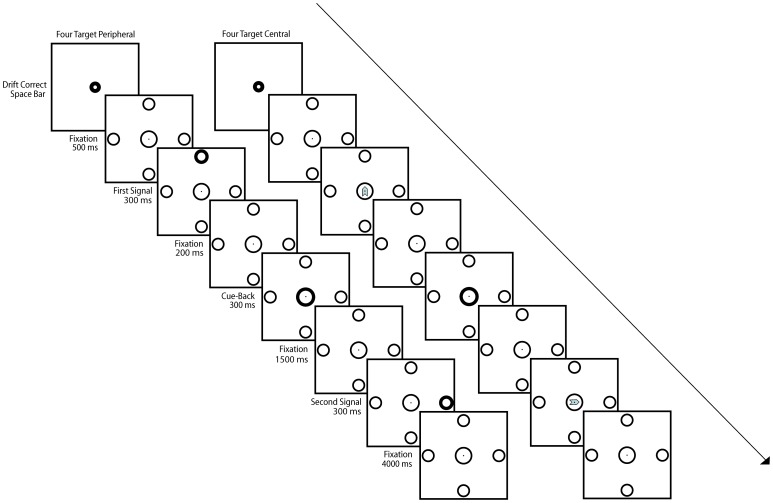
Sequence of Stimuli.Example stimuli and sequence timing from a single trial when peripheral (E1 and E3) and central (E2 and E4) signals were used to prompt responses. Each trial began with a drift correction procedure that required the participant to press the space bar with their left hand while fixating within the fixation circle. The fixation array was then displayed for 500 ms after which the first signal (S1) was displayed for 300 ms. Following the offset of S1, fixation was displayed for 200 ms followed by a cue-back stimulus (change of the fixation circle outline from 4 px to 8 px weight) for 300 ms. The fixation array (with all circles in 4 px weight) was again displayed for 1500 ms, providing ample time for participants to return their eye/arm to center prior to the onset of the second signal (S2). The S2 stimulus was added for 300 ms, followed again by an inter-trial interval of 4 seconds during which the fixation array was displayed. Participants were instructed to maintain fixation throughout the trial. During each trial, participants were asked to make an eye or arm movement to touch the center of the signalled targets as quickly and accurately as possible, and to return to center upon display of the cue-back, as well as after completing their S2 response. The overall fixation array was present throughout each trial, thereby providing a stable stimulus background while S1, S2, and the cueback were overlain as described above.